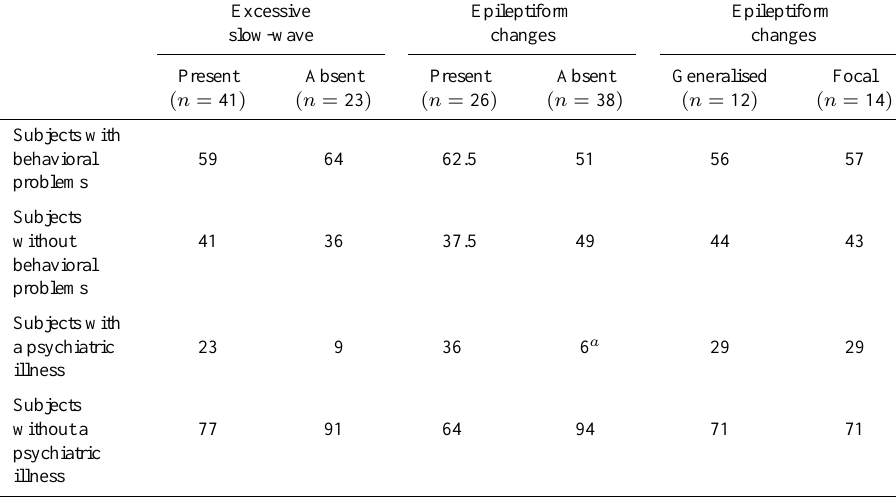
Table 3 Percentage of subjects with behavioural problems or psychiatric illness in different subgroups according to